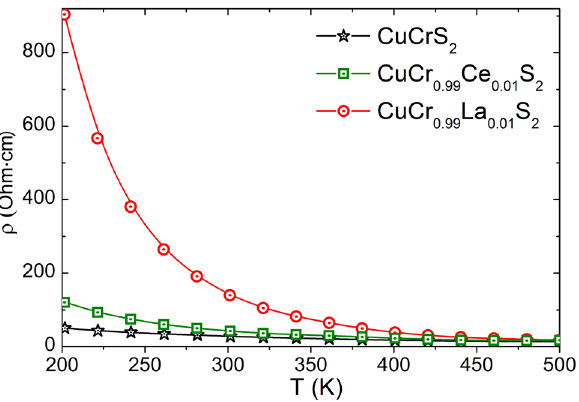
Figure 4. Temperature dependence of electrical resistivity for CuCrS 2 and CuCr 0.99 Ln 0.01 S 2 (Ln = La,